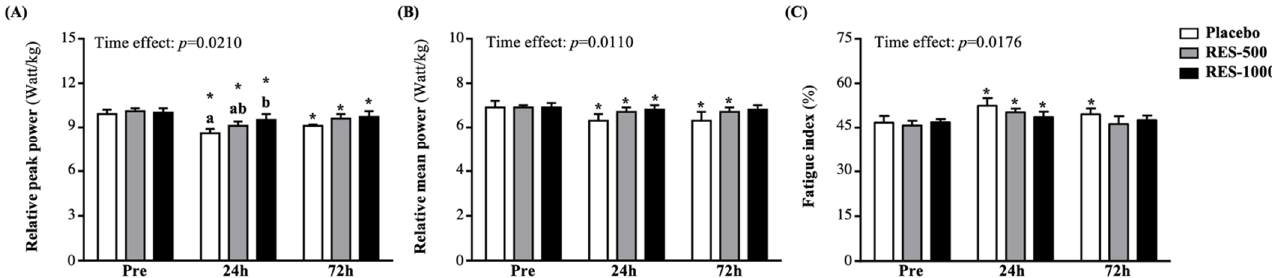
Figure 4. Effect of supplementation with RES on ( A ) relative peak power (RPP), ( B ) relative mean power (RMP), and ( C ) fatigue index. Data are presented by mean ± SEM. Different superscript letters (a, b) indicate significant differences among the groups at p < 0.05, and administration effects were statistically analyzed with a paired Student’s t -test, * p < 0.05.